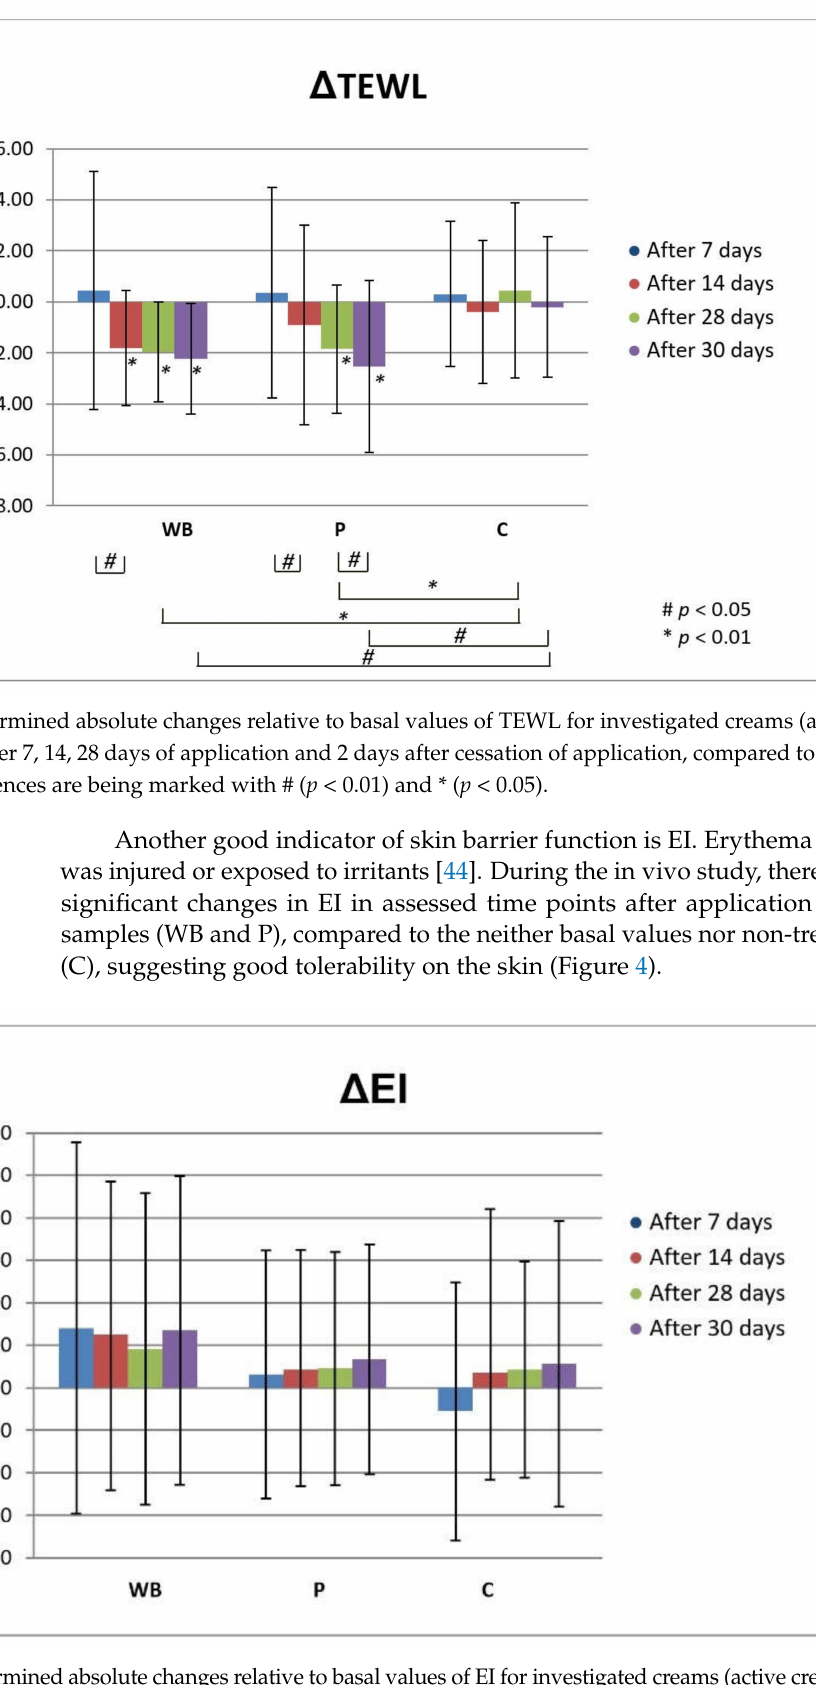
Figure 4. In vivo determined absolute changes relative to basal values of EI for investigated creams (active cream—WB, placebo cream—P) after 7, 14, 28 days of application and 2 days after cessation of application, compared to untreated control